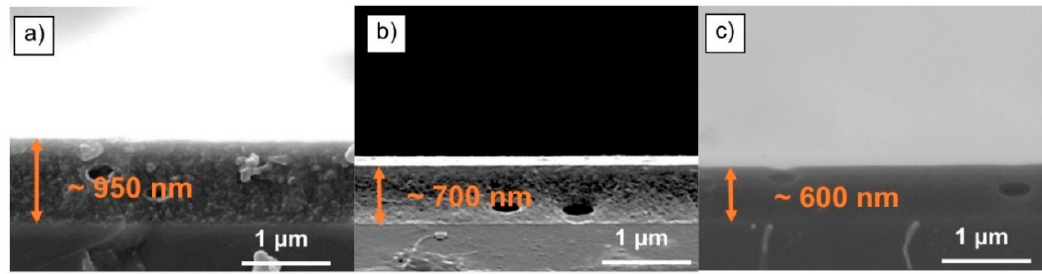
Figure 12. SEM cross-sectional images of hydrophobic coating C deposited by dip-coating, ( a ) as-deposited, and ( b ) after 500 h of UV exposure and ( c ) after 1000 h of UV exposure. The coating C reduced in thickness.